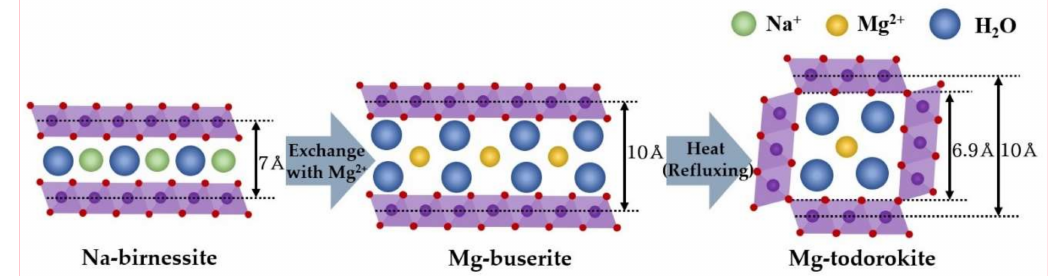
Figure 1. Synthesis procedure of Mg–todorokite and its